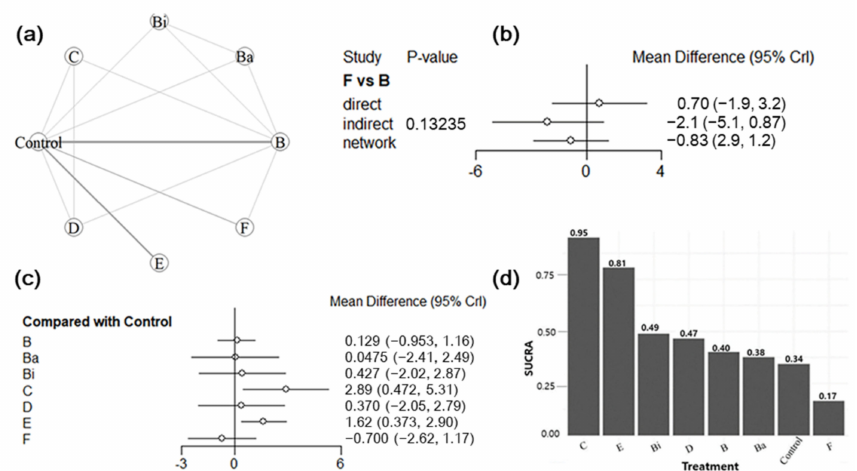
Figure 8. Results of the network meta-analysis of ETEC vaccines on average daily weight gain (ADWG) outcome. ( a ) Network graph for eligible treatment comparisons; each node represents one type of vaccine, the line connecting two nodes (edge) represents the evidence from direct treatment comparisons, and the edge thickness indicates how often treatments were compared in the primary trials. ( b ) Node split results for the assessment of inconsistency; ( c ) forest plot presenting the effectiveness of vaccines when compared with the control group; ( d ) SUCRA for each vaccine from the best to